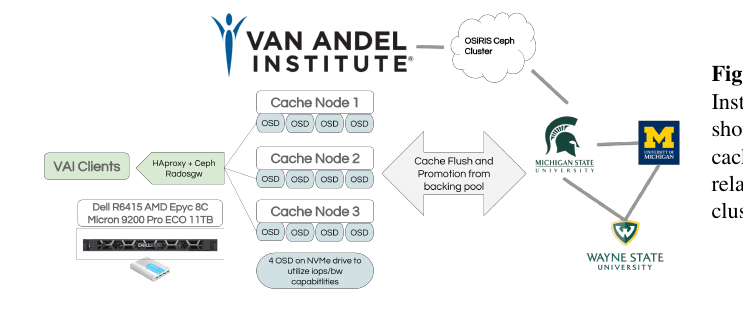
Figure 4. Van Andel Institute site architecture showing the arrangement of cache node hardware in relation to the OSiRIS cluster at other